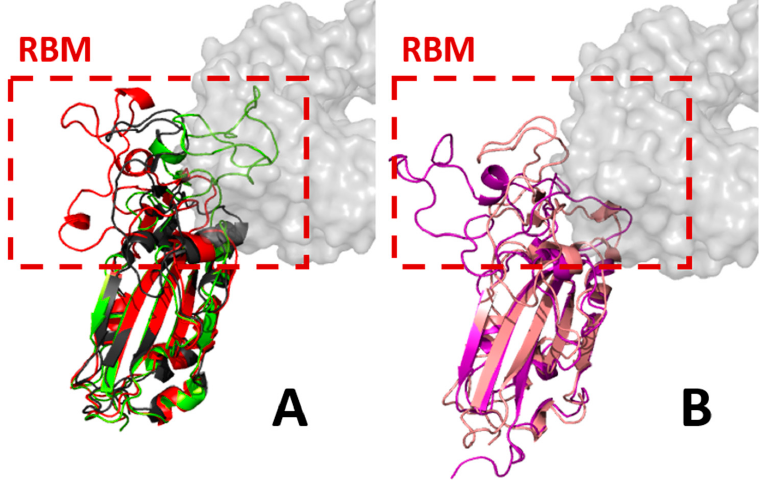
Figure 5. Conformations of RBD models. All models are aligned by C α atoms of the structured part of the RBD domain (a.a. 348–468). ( A ) Wild type (model 2 is red, model 4 is green, crystal structure 7cjf is black). ( B ) OM (model 2 is purple, and model 5 is salmon). The gray transparent surface at the top right of each panel represents the P4A1 antibody aligned with 7cjf RBD.